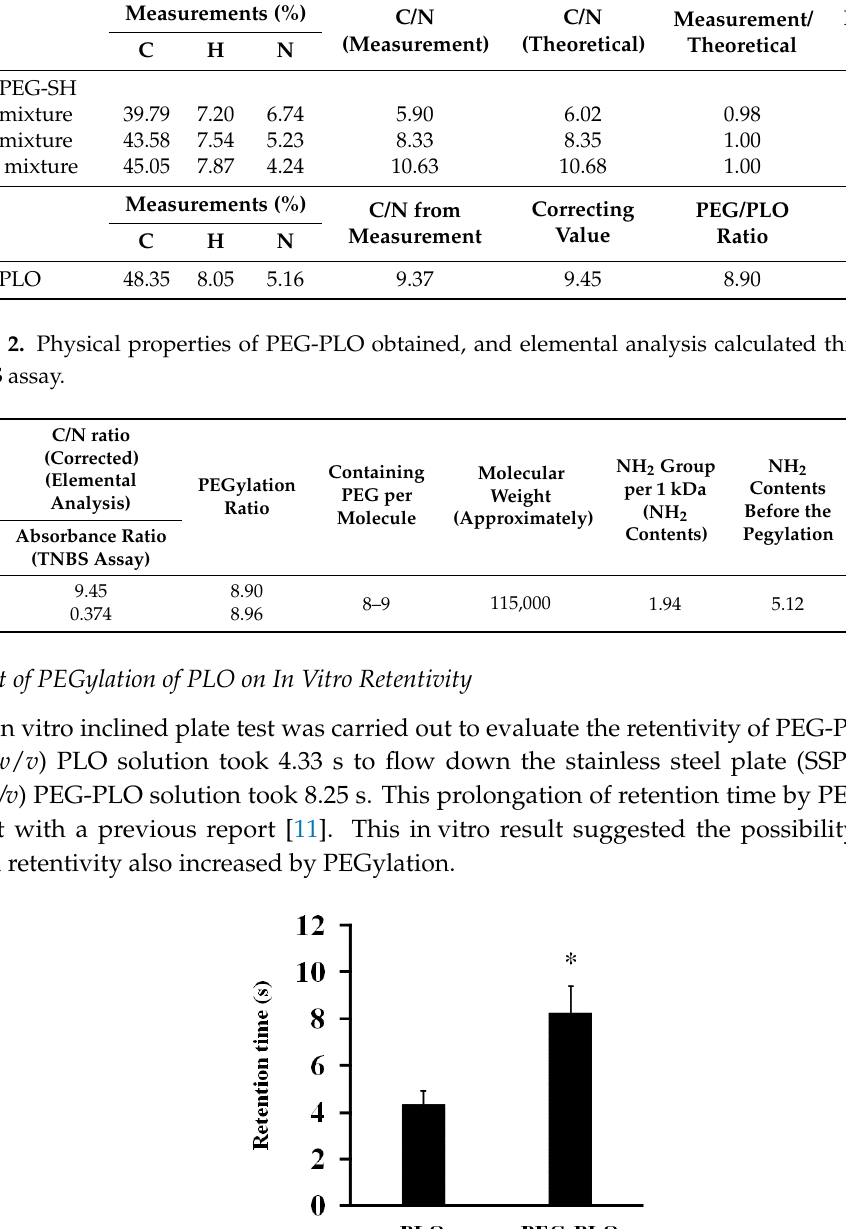
Figure 5. Effects of PLO and PEG-PLO on membrane conductance ( G t ) and permeability of fluorescein isothiocyanate dextran (FD-4) ( P app ) in Caco-2 cells. Relationship between G t and P app after application of PLO and PEG-PLO. Control group was treated with vehicle (HBSS). Each data column represents the mean ± S.E. ( n = 3–4). * p < 0.05 compared with the control group. 2.5. Cell Viability after Application of PEG-PLO Cytotoxicities of PLO and PEG-PLO were determined by MTT (3-(4,5-dimethyl-2- thiazolyl)-2,5-diphenyl-2 H -tetrazolium bromide) assay. The cell viabilities after application are shown in Figure 6. PLO was decreased the cell viability at 1.0 μ M, a concentration that enhanced permeation. Furthermore, the viability decreased significantly at the higher concentration (4.0 μ M). On the other hand, PEG-PLO showed no cytotoxicity even at the highest concentration in this study. These results suggested that the conjugation of PEG was important for reduction of the cytotoxicity of PLO.